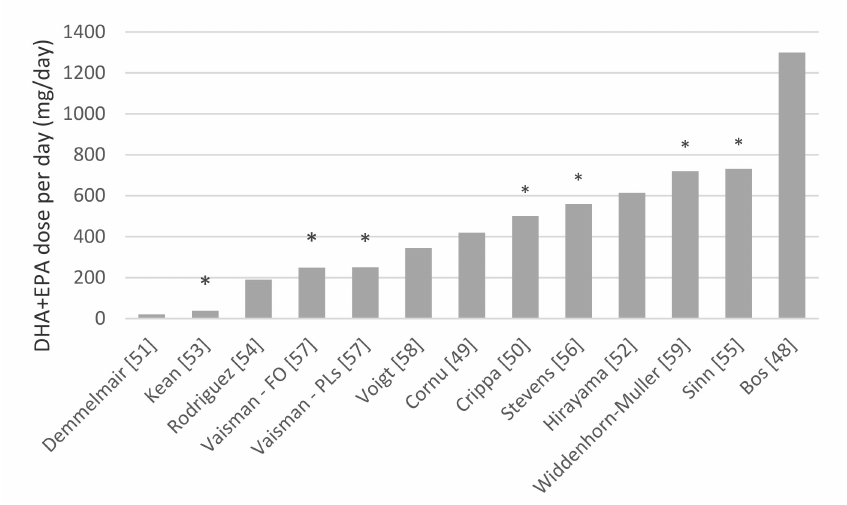
Figure 4. n -3 long-chain polyunsaturated fatty acids (LCPUFA) supplementation studies that studied cognition in children and adolescents with a disease or disorder. Studies indicated with a * are those studies in which positive e ff ects of supplementation are reported. Note that in the study of Demmelmair et al. and Cornu et al., dose di ff ered based on bodyweight—the dose noted here is the lowest dose. Note that the study of Vaisman et al. included two n -3 LCPUFA dose groups (fish oil (FO) and n -3 LCPUFA containing phospholipids (PLs)), these are reported separately